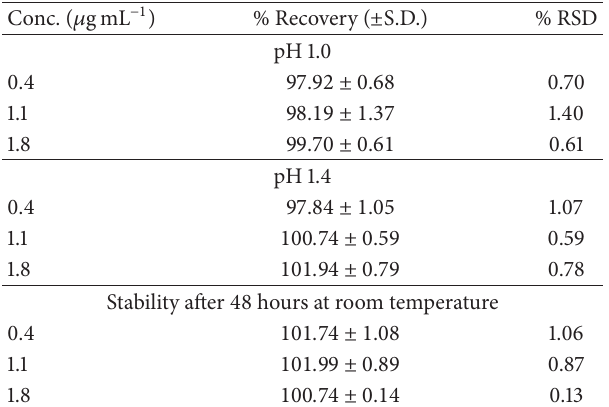
Table 6: Robustness data for the proposed